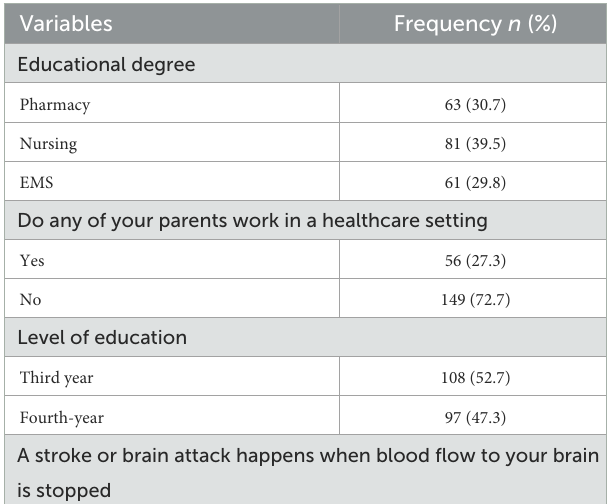
TABLE 1 Demographic characteristics of the